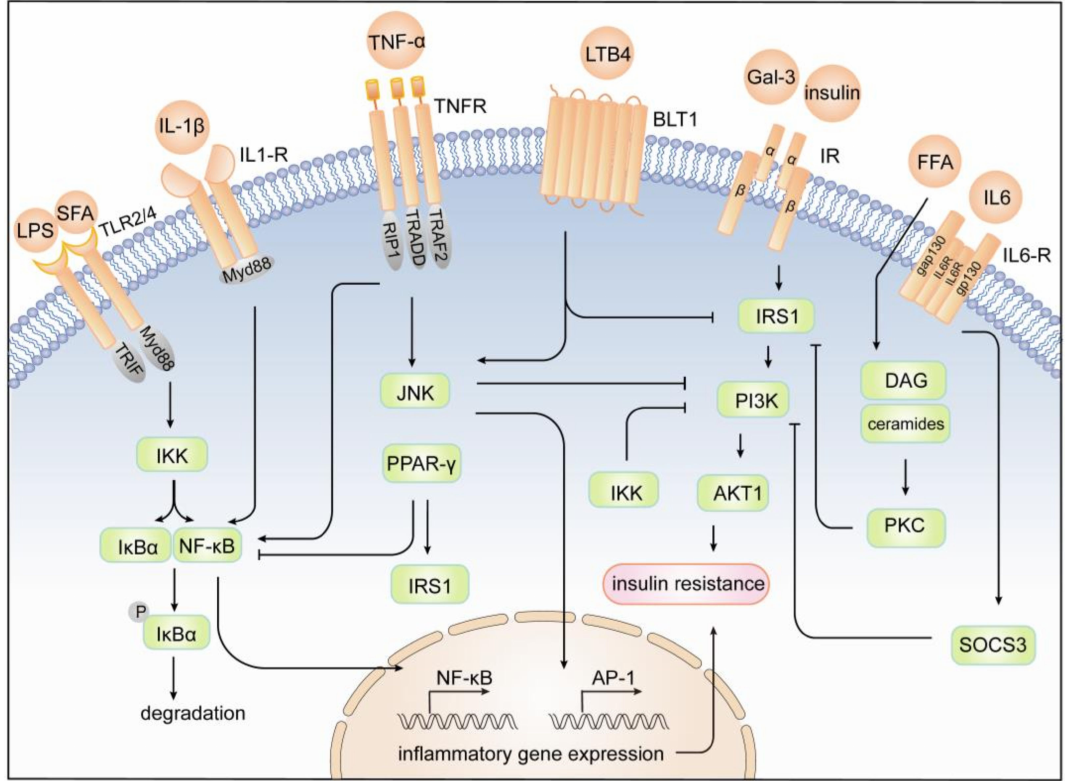
Figure 2. Cytokines regulate insulin sensitivity in insulin target cells. Activation of the insulin receptor leads to tyrosine phosphorylation of IRS-1 and initiates insulin signal transduction. Activation of TLR2/4 and TNFR results in the promotion of NF- κ B and JNK signaling pathways. The serine kinases IKK and JNK-1 could reduce the signaling of IRS-1 and impair downstream insulin signaling. Moreover, the activation of IKK causes phosphorylation and degradation of I κ B; thus, NF- κ B could translocate into the nucleus. JNK promotes the formation of the AP-1 transcription factor, which in turn transactivates inflammatory gene expression by NF- κ B and AP-1, further contributing to insulin resistance. PPAR- γ suppresses the NF- κ B transcription activity and upregulates IRS protein, which favors the improvement insulin sensitivity. LTB4 promotes JNK activation through BLT-1 and leads to subsequent IRS-1 serine phosphorylation, ultimately promoting cellular insulin resistance. Gal-3 directly inhibits the insulin receptor and impairs all the major steps in the insulin signaling pathway. Additionally, IL6 induces SOCS-3 and leads to proteasomal degradation of IRS-1 through binding to the IL-6 receptor. IL-1 β stimulates the translocation of NF- κ B to the nucleus through IL-1R1, promoting inflammatory gene expression. Also, lipid metabolites, including FFAs, ceramides, and DAG, activate the PKC to impair IRS-1, which directly interfere with insulin